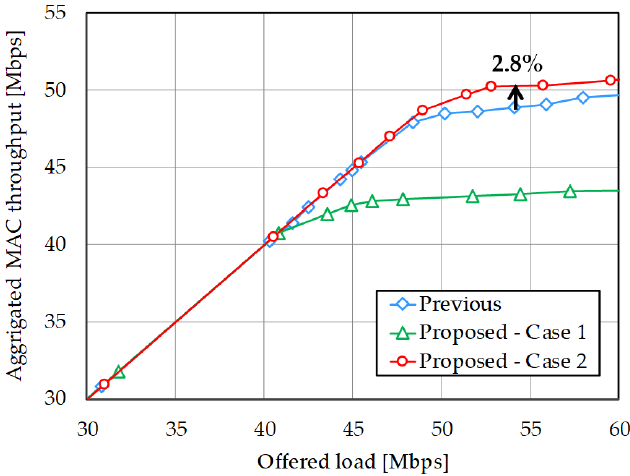
Figure 9. Aggregated MAC level throughput in practical topology. Table 5. Saturated throughput values in practical topology.